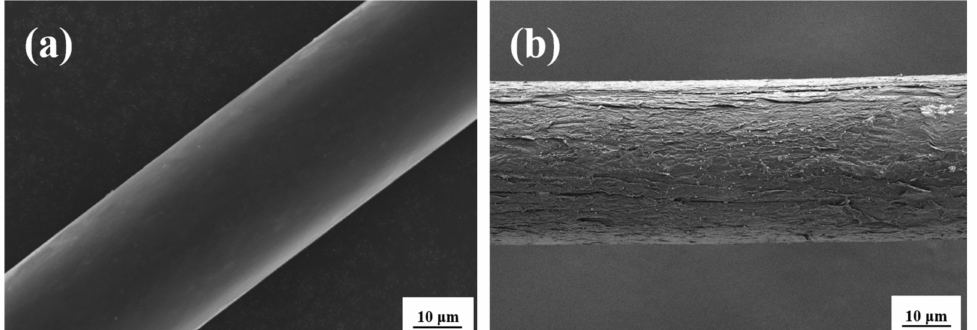
Figure 1. SEM image of PP fiber: ( a ) untreated; ( b )